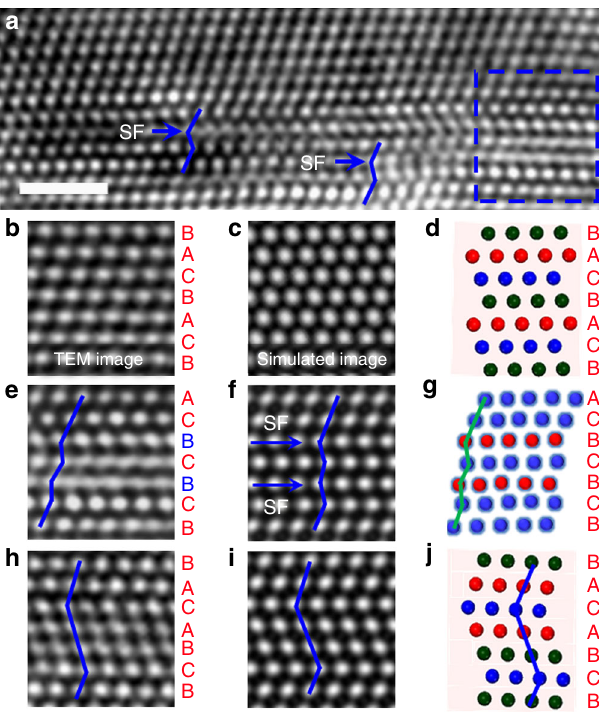
Fig. 2 HRTEM images and associated schematic illustrations showing the nucleation of a three-layer twin. a An enlarged HRTEM image corresponding to Fig. 1b. b A local region in a showing the perfect FCC lattice structure. c Simulated HRTEM image corresponding to b . d (cid:2) partial dislocation on the Schematic of the ABCABC stacking sequence in an FCC lattice. e An enlarged view of the boxed region in a . f Simulated HRTEM image corresponding to e . g Schematic of two SFs separated by one atomic layer (i.e., 1 – 3 SFs), as derived from the HRTEM image in e . The atomic layer with red atoms indicates the SF. h An enlarged HRTEM image showing a three- layer twin. i Simulated HRTEM image corresponding to h . j Schematic illustration of three-layer twin formed by nucleation of a SF in between 1 – 3 SFs. The scale bars are for 1